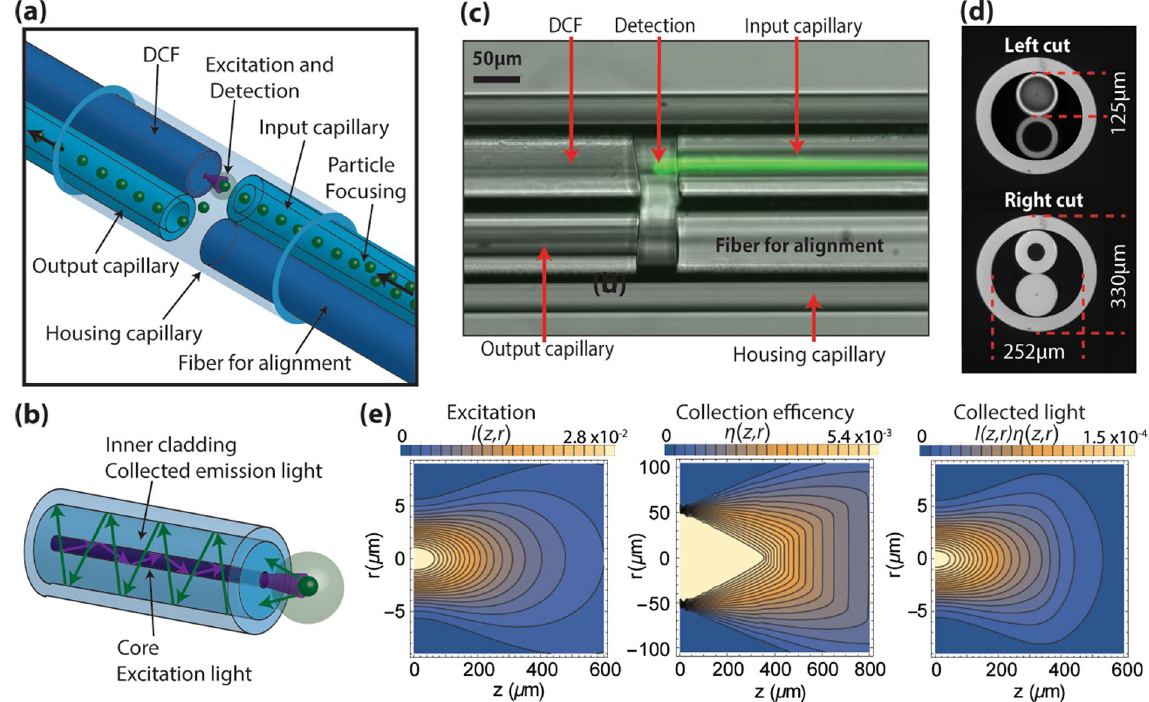
Figure 1. Fibre-based microflow cytometer. ( a ) Integrated detection micro-chamber; ( b ) Detection principle of the double-clad optical fibre (DCF); ( c ) Image of the micro-chamber during operation. The green light is fluorescence from particles flowing through the input capillary and excited by light from the DCF; ( d ) Cross- sectional views of the micro-chamber; ( e ) Simulated bi-dimensional map of: (left) excitation from the DCF core (9- µ m diameter), (centre) collection efficiency of the DCF inner cladding (105- µ m diameter and 0.2 NA), and (right) light collected by the DCF. An excitation wavelength 450 nm and a medium refractive index 1.33 (water) are used for the